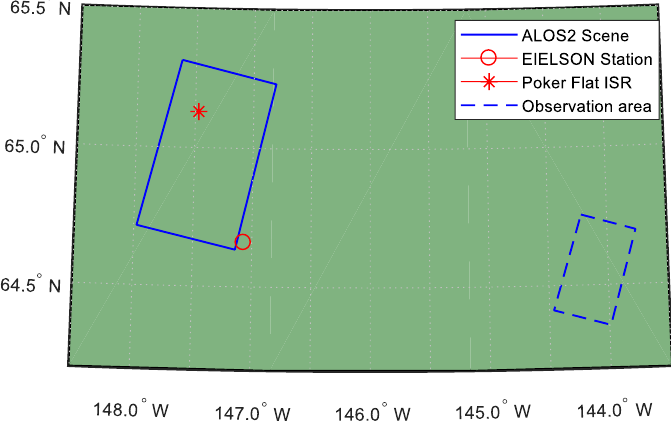
Figure 2. Geographic relationship of ALOS-2 scene, EIELSON station, and Poker ISR station.